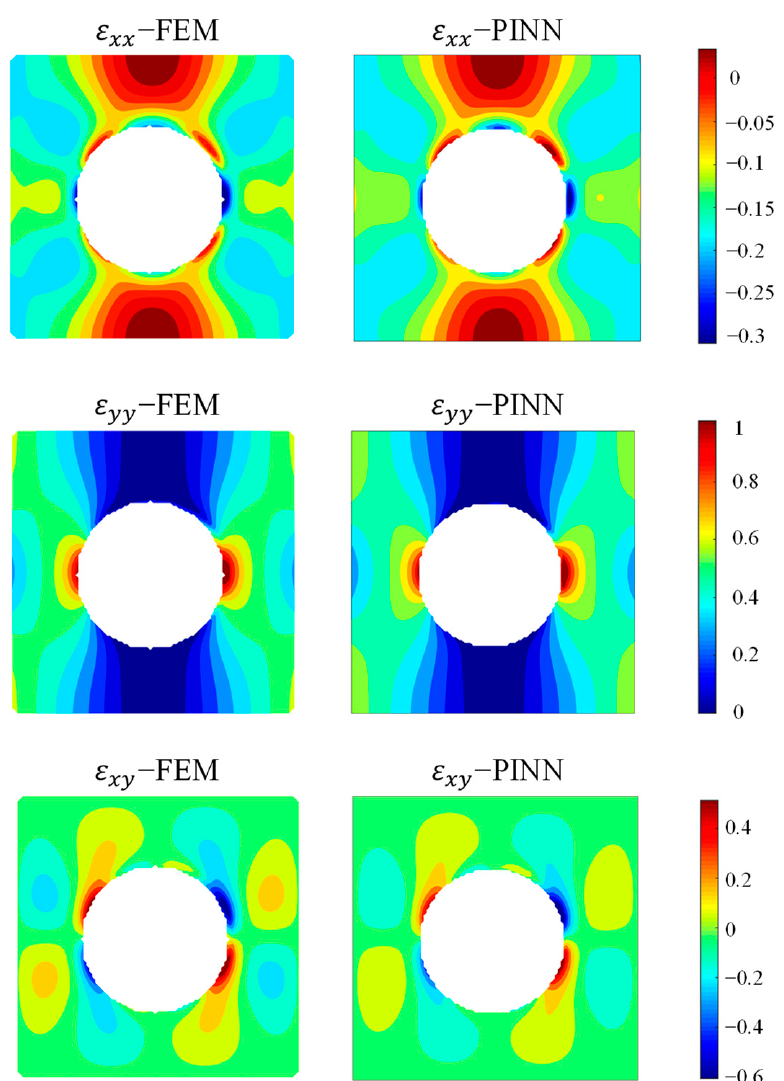
Figure 7. Comparison of the obtained strain fields ( left : FEM; right : PINN) of the in-plain stretching- related solid mechanics problem.